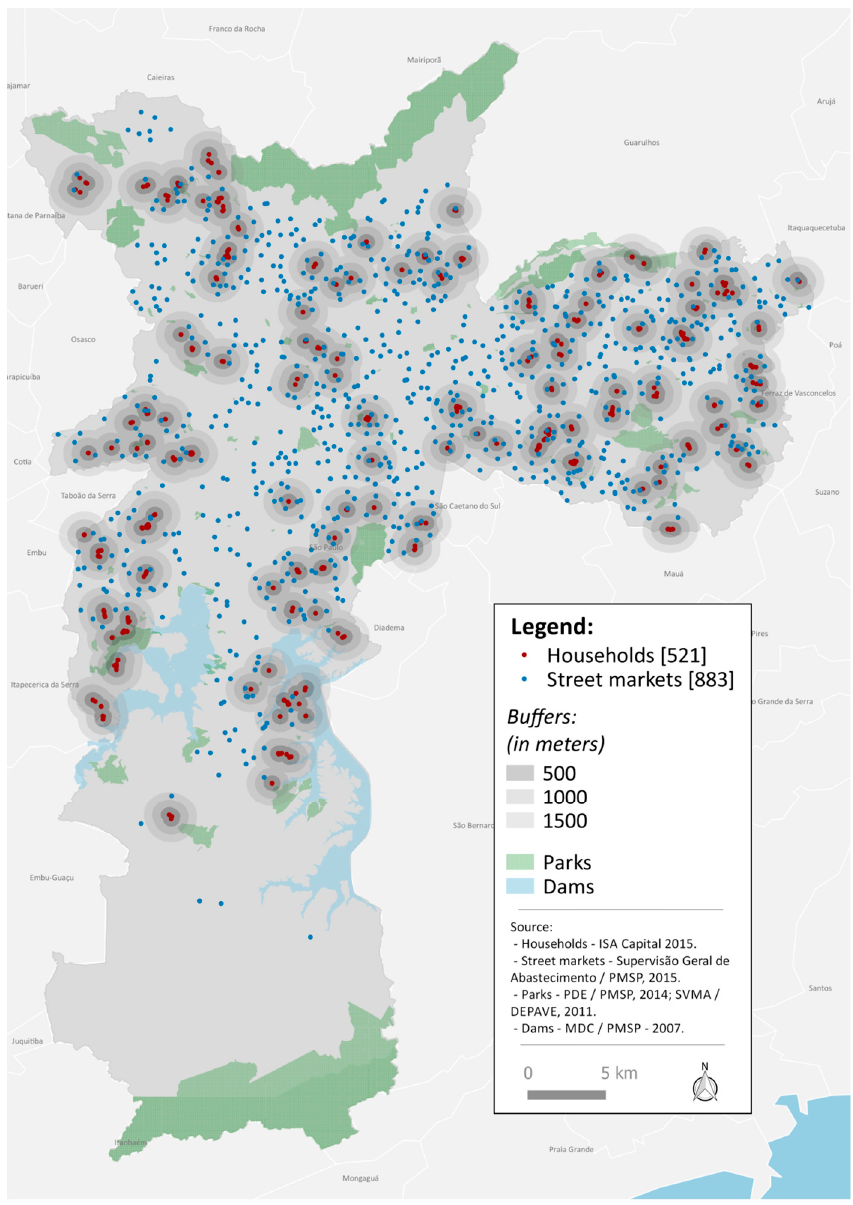
Figure 2. Spatial distribution of street markets in the São Paulo city and adolescent households. ISA-Capital, São Paulo, Brazil, 2015.